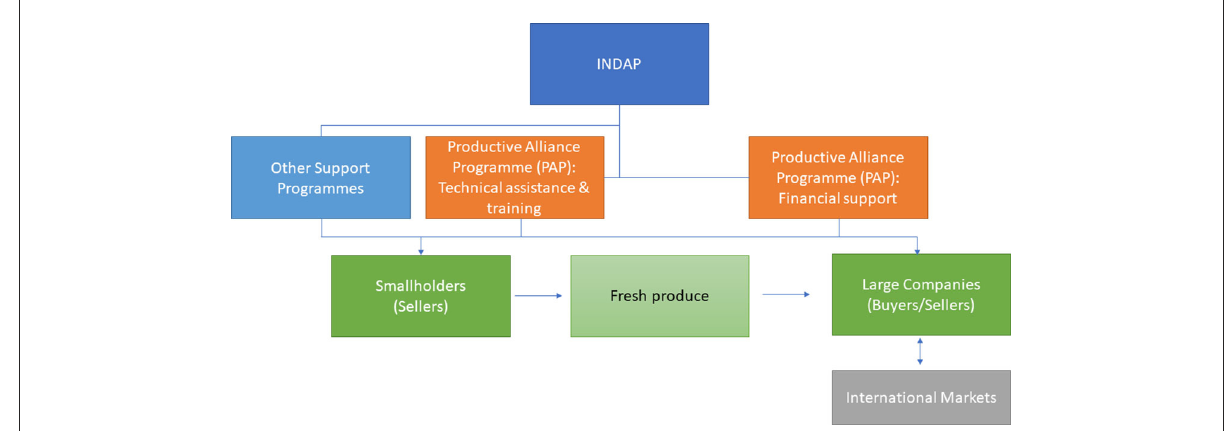
FIGURE1 Process flow chart of the PAP. Source: Own elaboration.